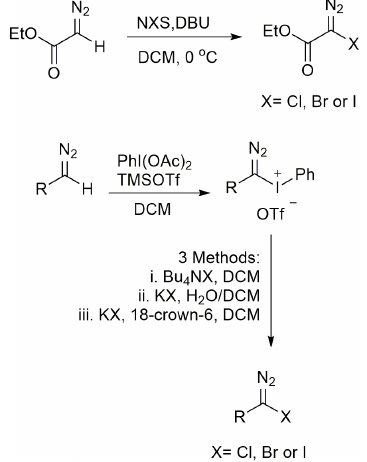
Figure 45 - Halogenation of diazocetates.